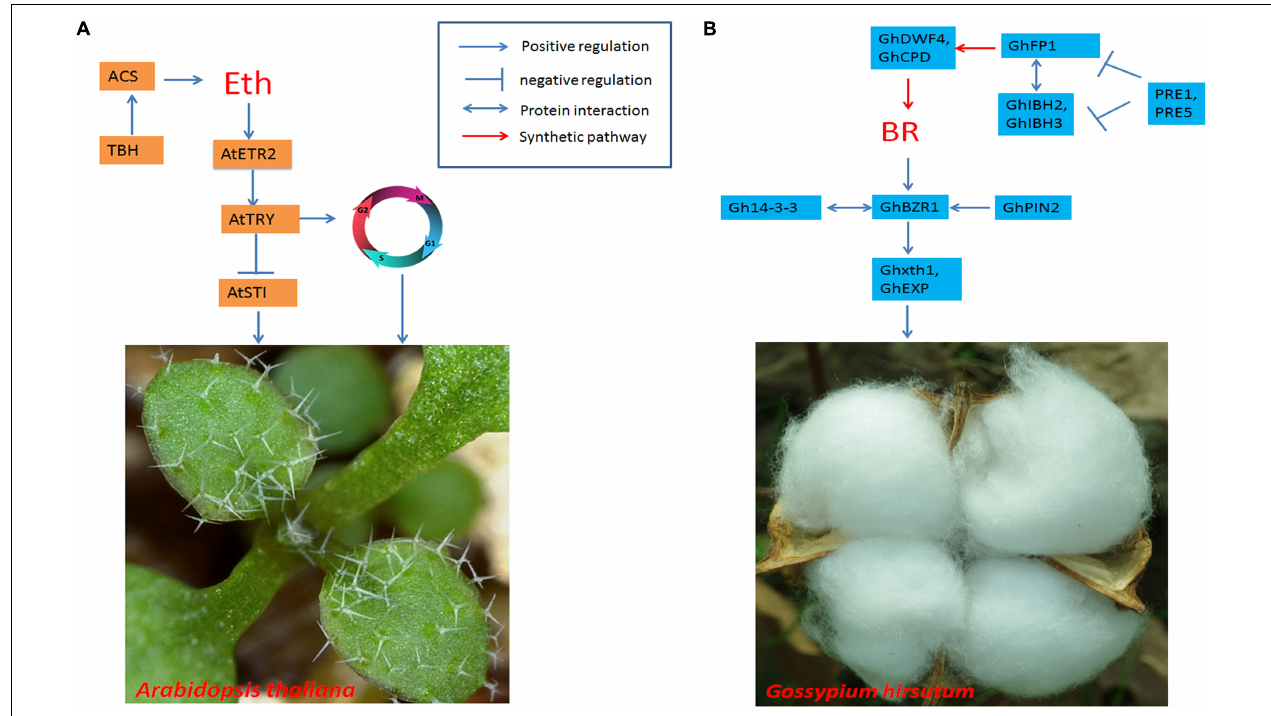
FIGURE 5 | Regulatory networks of trichome development induced by ethylene and for cotton fiber regulated by BRs. (A) Ethylene regulates the expression of AaTRY, which is a negative regulator of trichome development in Arabidopsis. It also affects trichome initiation via its involvement in cell endoreduplication. (B) BRs activate GhBZR1, which is an important transcription factor that regulates BR-responsive gene expression. GhBZR1 promotes the expression of Ghxth1 and GhEXP to modulate fiber initiation in